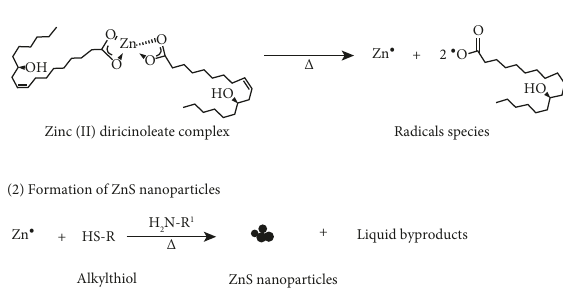
Figure 1: Reaction scheme showing the thermal decomposition of zinc (II), ricinoleate complex, and the formation of ZnS nano- particles in dodecanethiol:oleylamine (1 :1) solvent mixture at temperatures 240 ° ≥